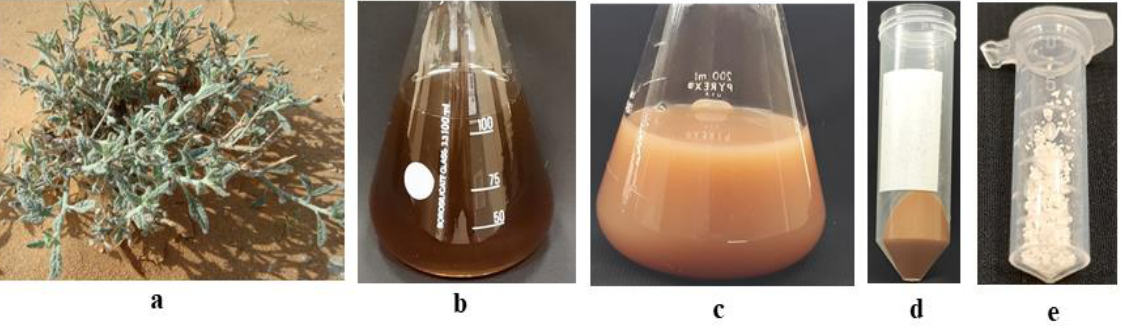
Figure 2. Biosynthesis of ZnO-NPs using the aqueous leaf extract of Heliotropium bacciferum : ( a ) H . bacciferum in natural habitat; ( b ) aqueous leaf extract; ( c ) synthesized ZnO-NPs; ( d ) ZnO-NPs in pelleted form with secondary metabolites; ( e ) powder form of synthesized ZnO-NPs .